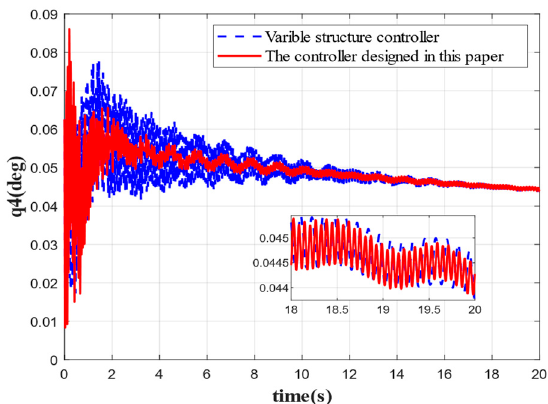
Figure 15. Third ‐ order elastic vibration mode with external interference. Figure 15. Third-order elastic vibration mode with external interference.